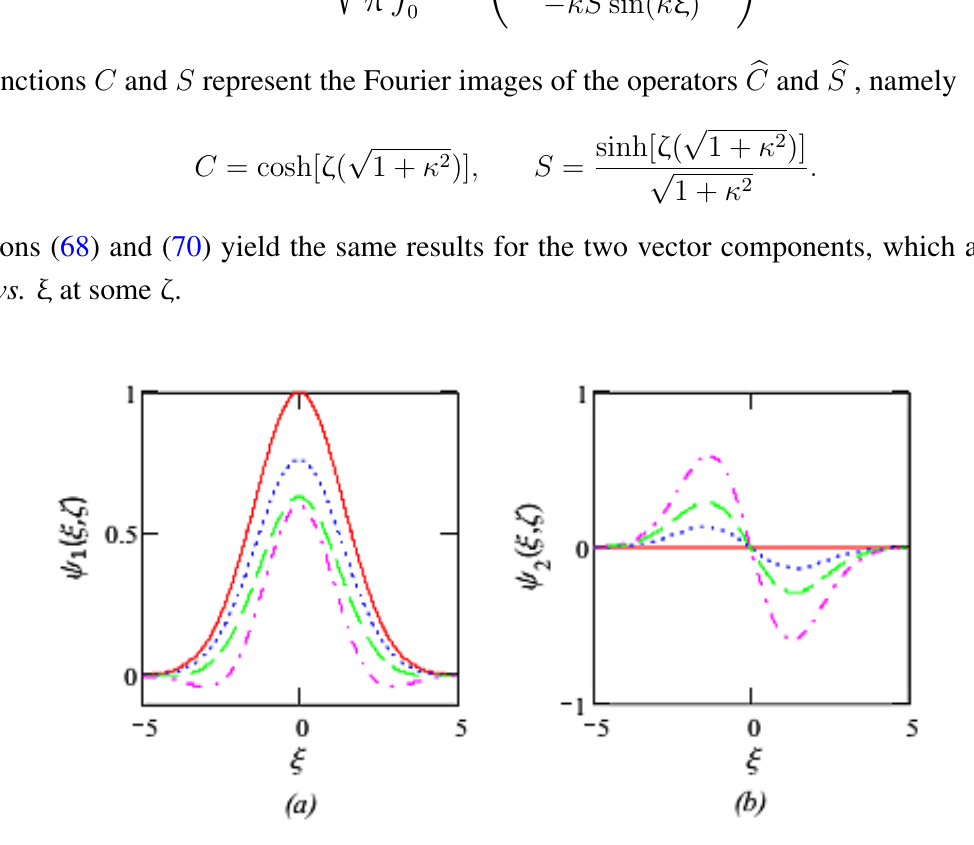
( ξ , ζ ) and ( b ) ψ ( ξ , ζ ) of the ψ -vector 1 2